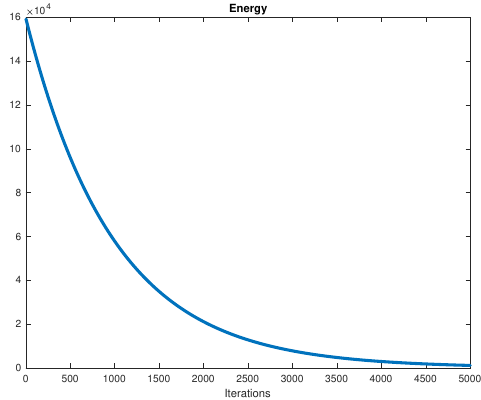
Figure 1. (a) AMSU-B image at 15 km resolution, (b) AVHRR image at 1.9 km resolution, and (c) data fusion result at 1.9 km resolution are shown.